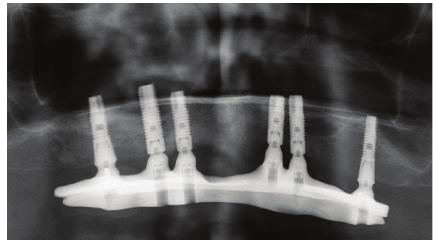
Figure 3: Situation 3 years postoperatively.